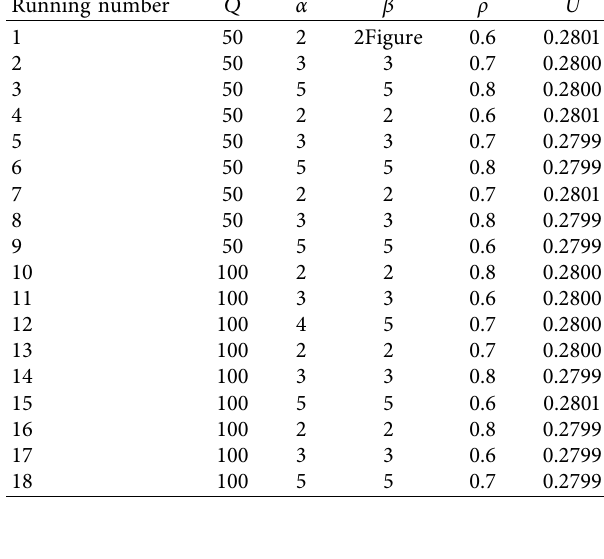
Table 12: The orthogonal test table.